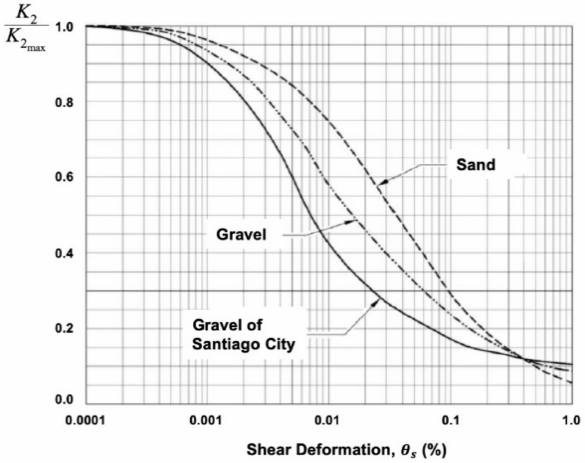
Figure 4. Normalized seismic shear coefficient for granular